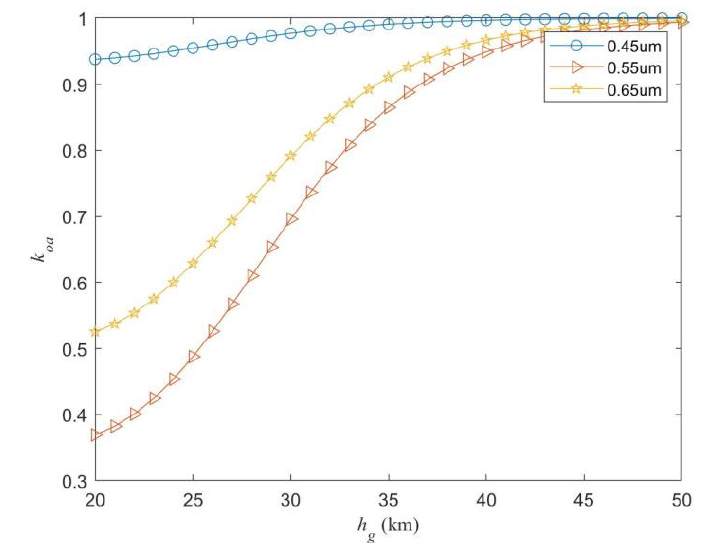
k Figure 8. oa with the tangent